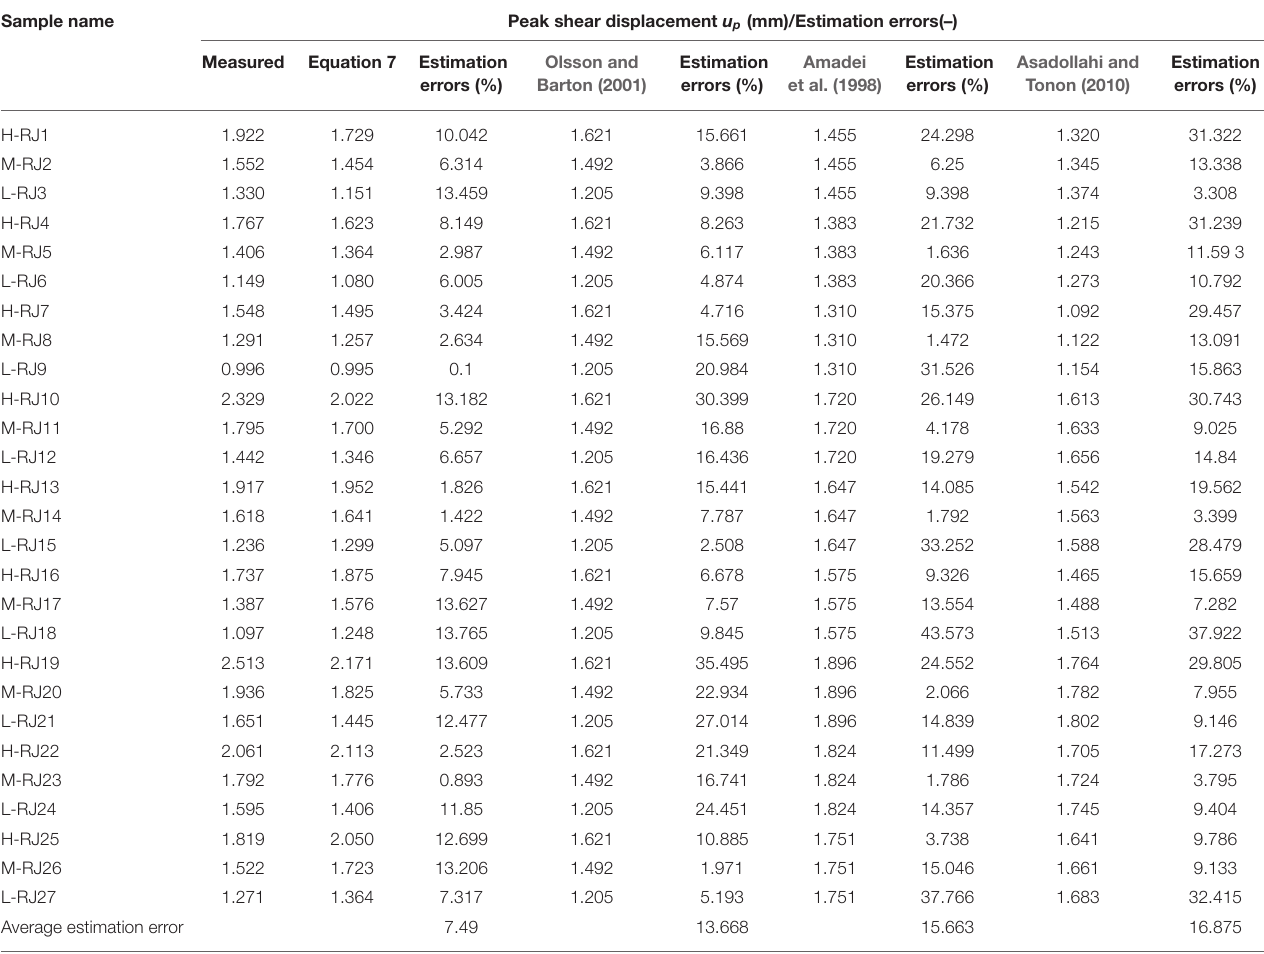
TABLE 3 | Comparison of the experimental peak shear displacement and the predicted peak shear displacement of different